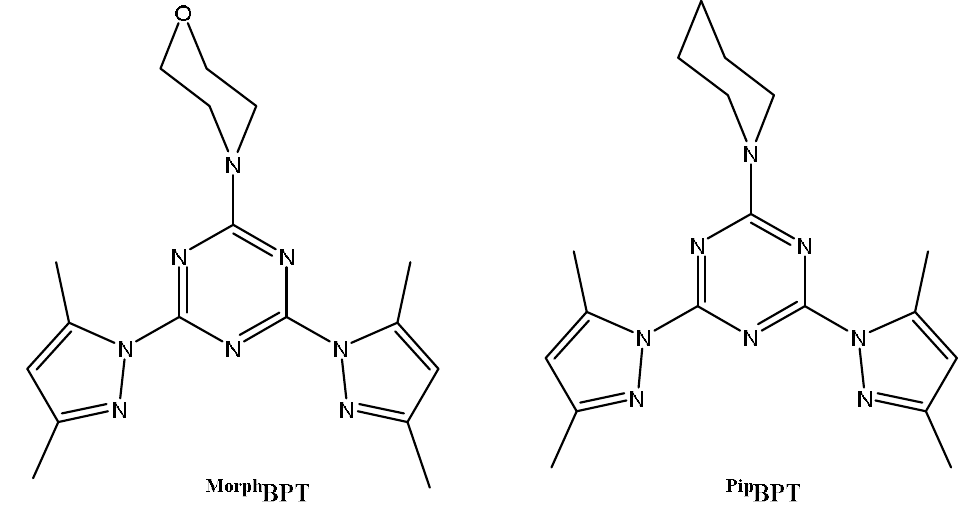
Figure 1. Structure of the pincer ligands.